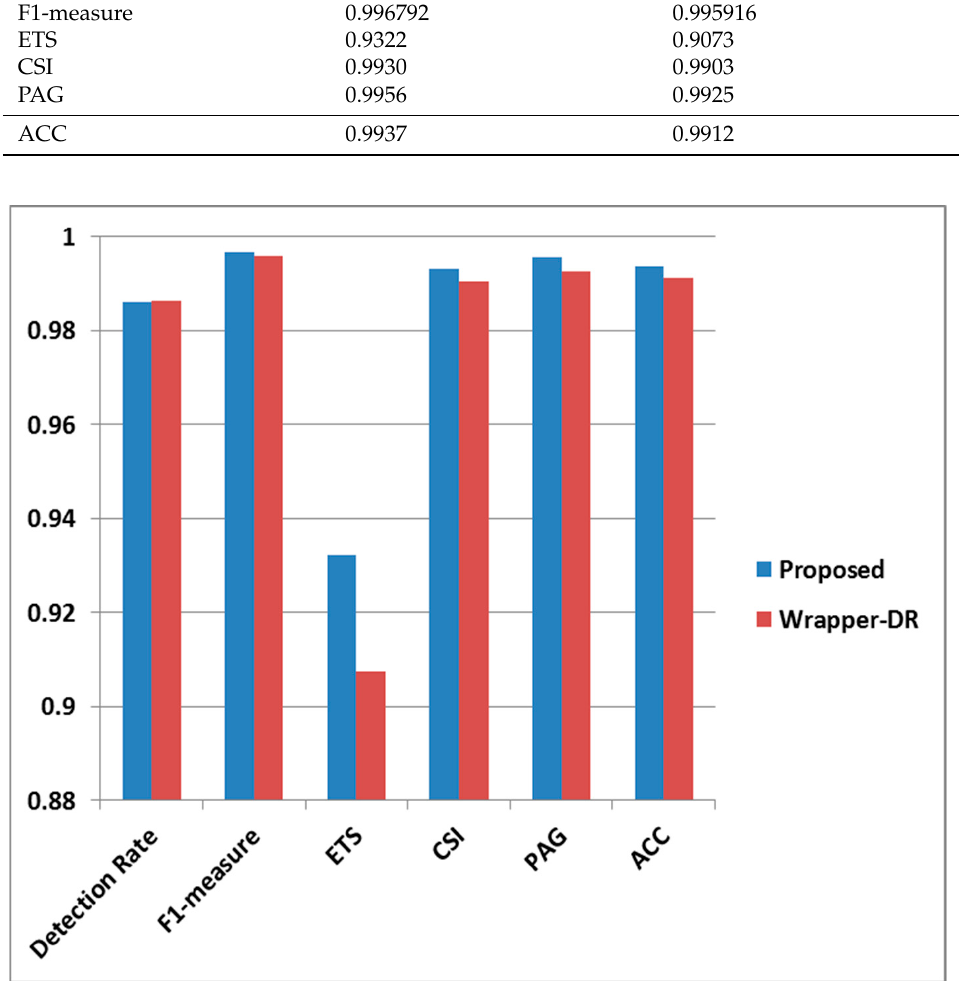
Figure 13. Result of binary decoding: graph.